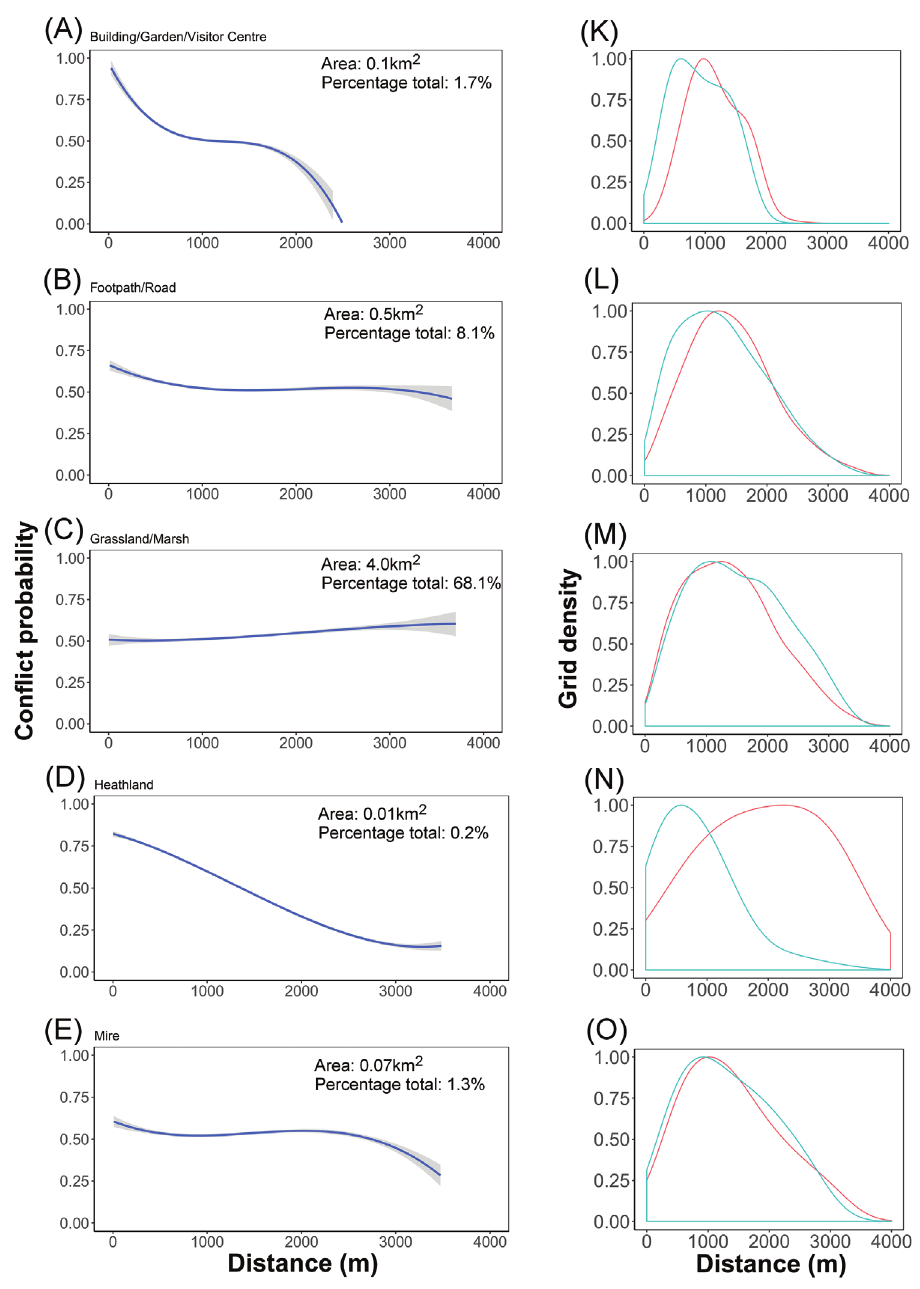
Figure 51. A–e human-deer ( Cervus elaphus ) encounter probability modelled with distance to each feature. The 95% confidence intervals are shown in grey K–o Density distribution of randomly sampled high-encounter points (blue) and low-encounter points (red) modelled with distance to each feature. Data collected from Lyme Park, Disley, UK, in